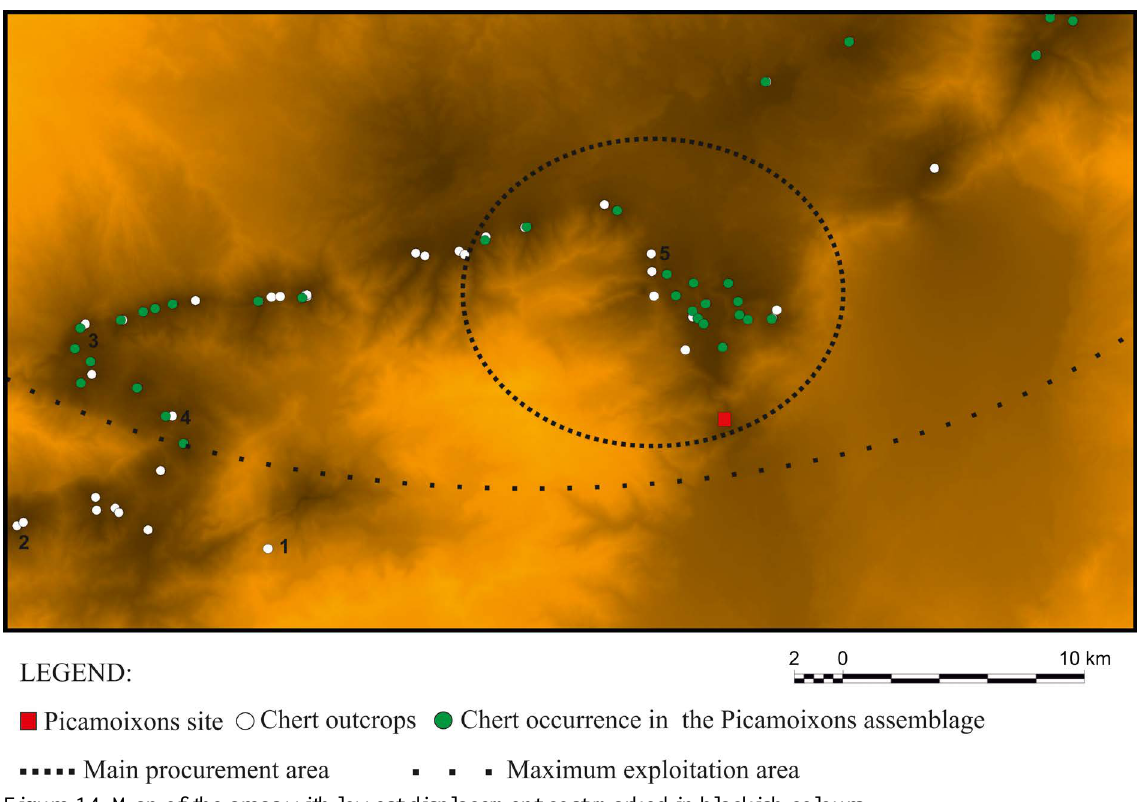
Figure 14. Map of the areas with lowest displacement cost marked in blackish